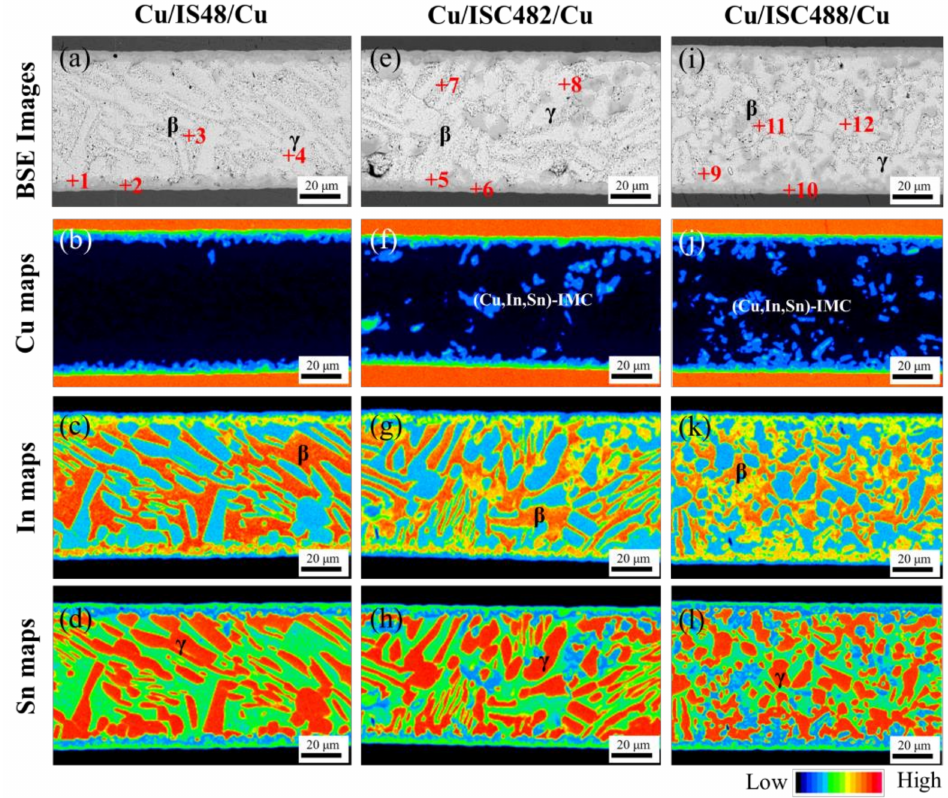
Figure 3. The high-magnification view of the cross-sectional BSE and EPMA images of the: ( a – d ) Cu/IS48/Cu joint, ( e – h ) Cu/ISC482/Cu joint, and ( i – l ) Cu/ISC488/Cu joint; and the loca- tions (1–12) of the EPMA points listed in Table 2. Where β and γ correspond to In 3 Sn and InSn 4 phases, respectively. The plus symbols represent the locations of the analysis points. Table 2. Chemical composition of the marked points in Figure 3. Alloy Joint Point In (at.%) Sn (at.%) Cu